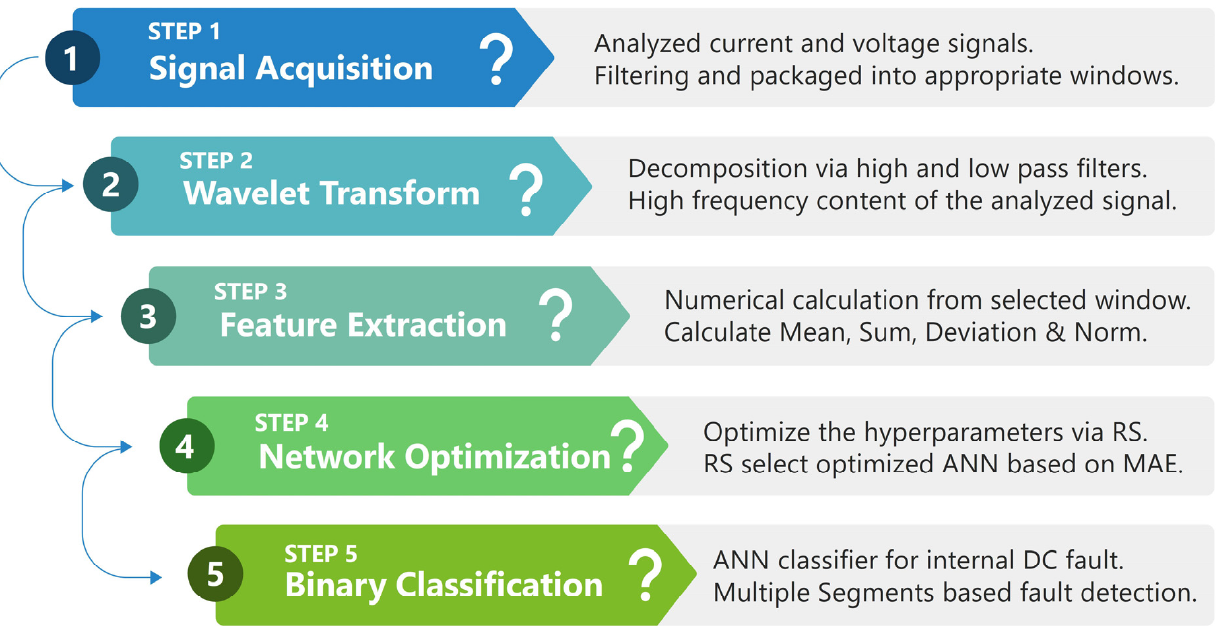
Figure 4. Schematic diagram of the proposed algorithm. Table 1. Case studies for internal faults in training data.